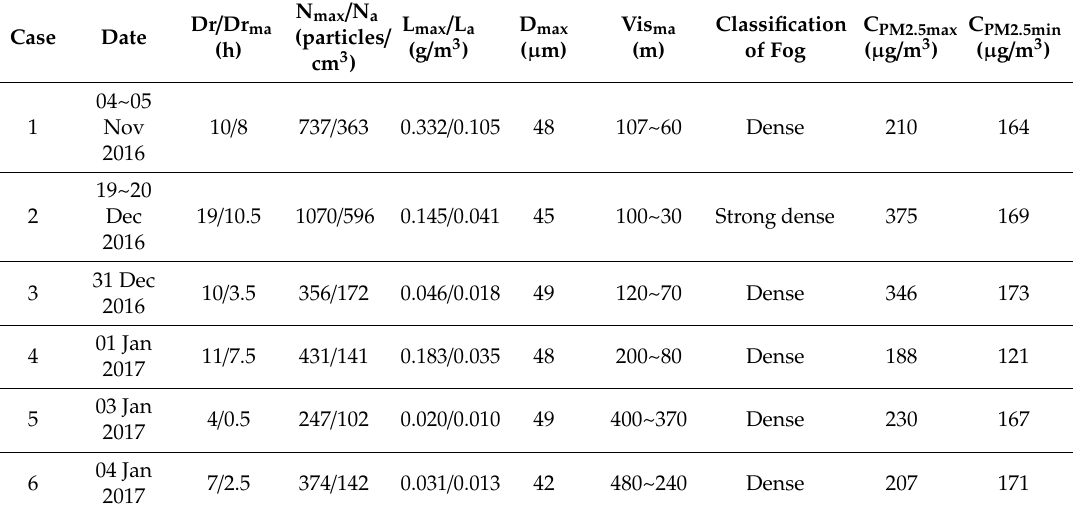
Table 2. Microphysical parameters and C PM2.5 of the six fog processes in